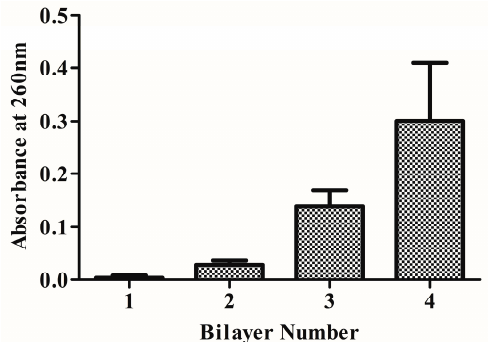
Figure 2. UV–vis absorbance of multilayered films at 260 nm as a function of layer number ( n =